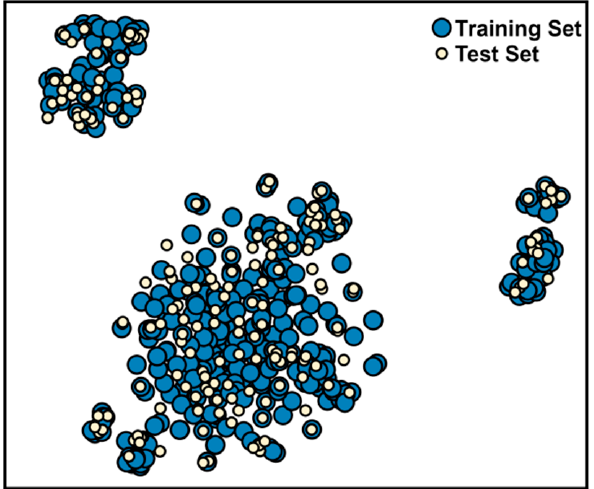
Figure 11. Chemical space distribution of training (blue) and test (cream) sets of the complete RIPK1 inhibitors dataset.